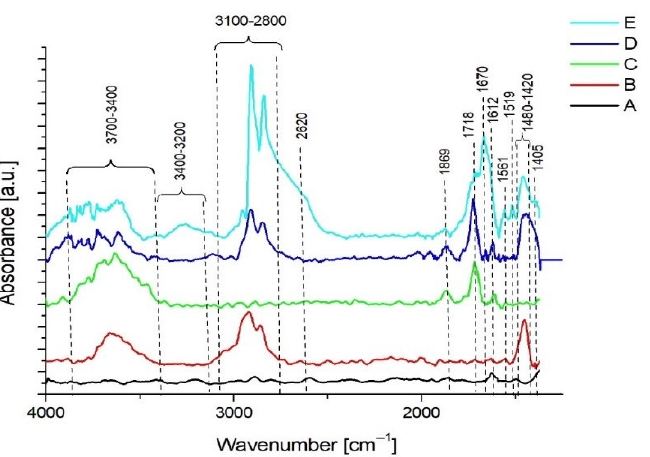
Figure 3. Summary of FTIR spectra for subsequent graphene modifications—unmodified graphene (A), graphene after modification with hydrogen plasma (B), graphene after oxidation in H 2 SO 4 (C), graphene after modification with hydrogen plasma and after oxidation in H 2 SO 4 (D), graphene after modification with hydrogen plasma and H 2 SO 4 and attached glutathione (E).